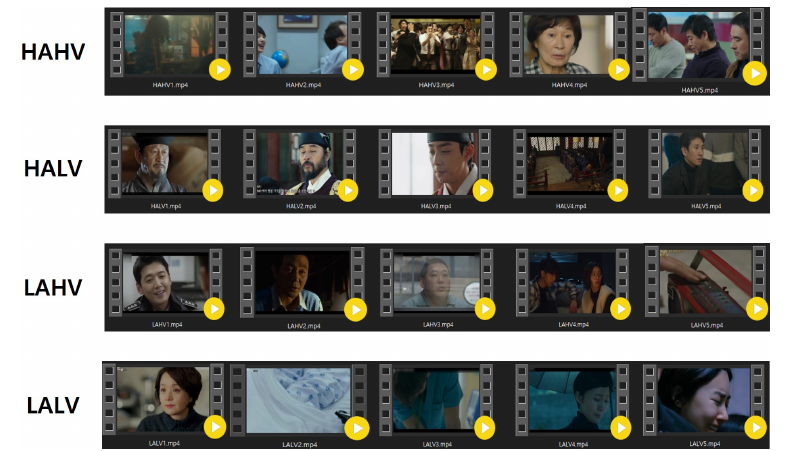
Figure 5. Five video clips per each emotional dimension.